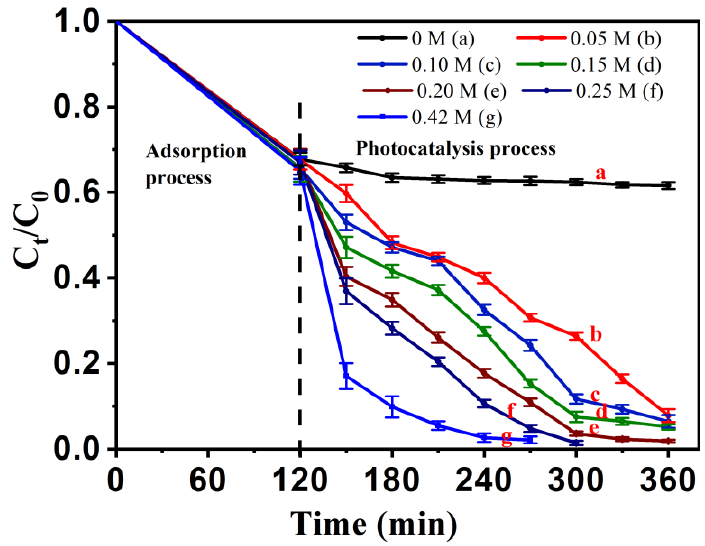
Figure 10. The ability to degrade RP 100 ppm of CuH–3.5 at different H 2 O 2 concentrations.